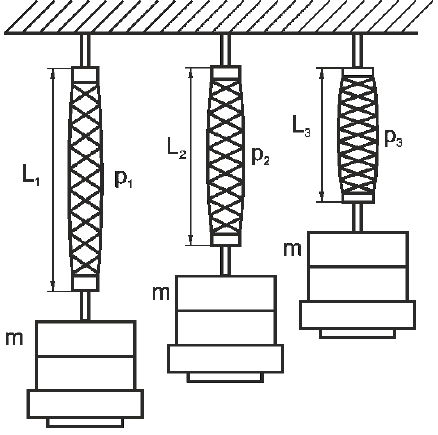
Fig. 7. The principle of determining the isotonic characteristics of the pneumatic artificial muscle.